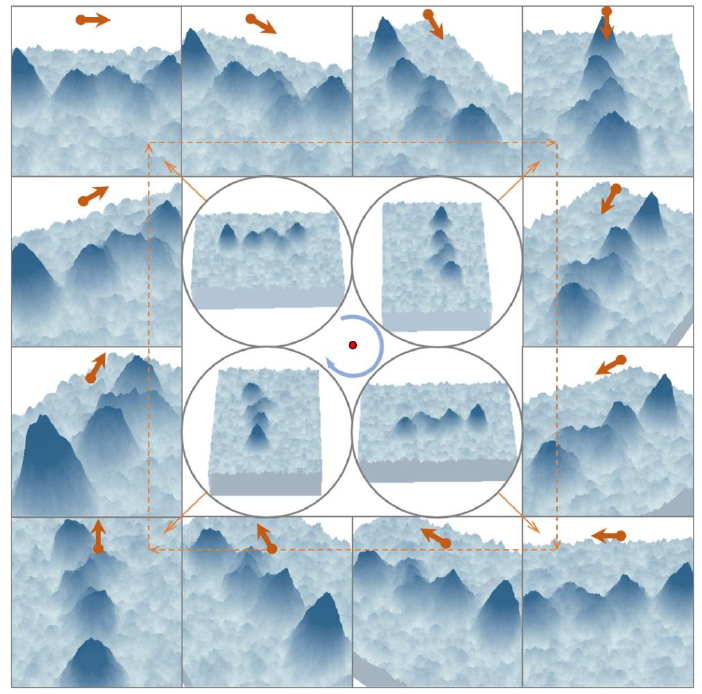
Figure 18. The same terrain from different directions.